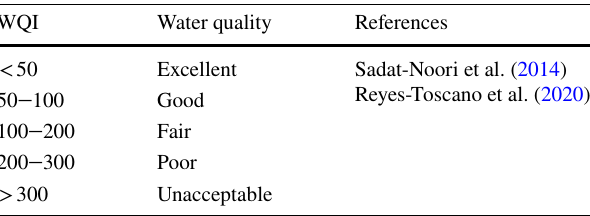
Table 2 Classification of water quality index WQI Water